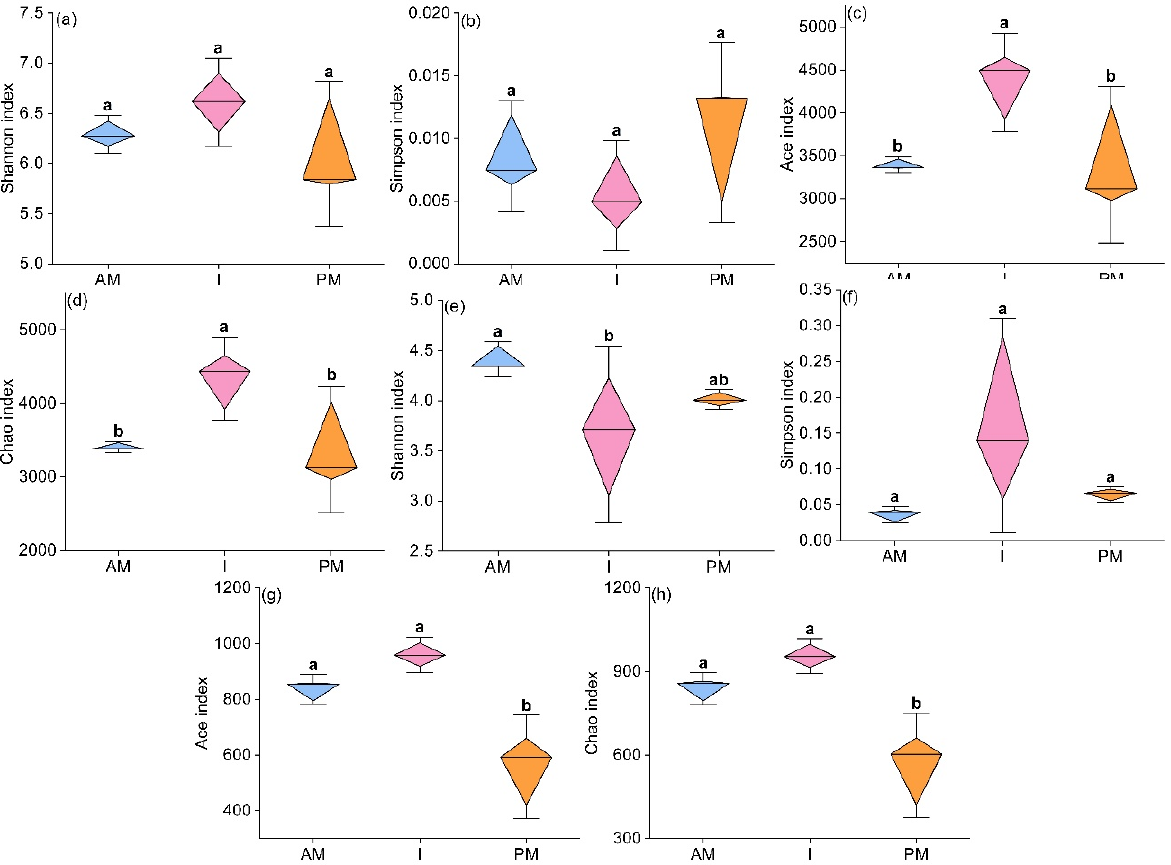
Figure 3. Changes in soil microbial alpha diversity index under different planting patterns (( a – d ): bacteria; ( e – h ): fungi). Different letters indicate significant differences (ANOVA, p < 0.05, and Tukey’s HSD post hoc analysis) among different planting modes. AM represents areca nut monocropping; I represents areca nut intercropping with pandan; and PM represents pandan monocropping. Different lowercase letters indicate significant differences between treatments under the same index ( p < 0.05).